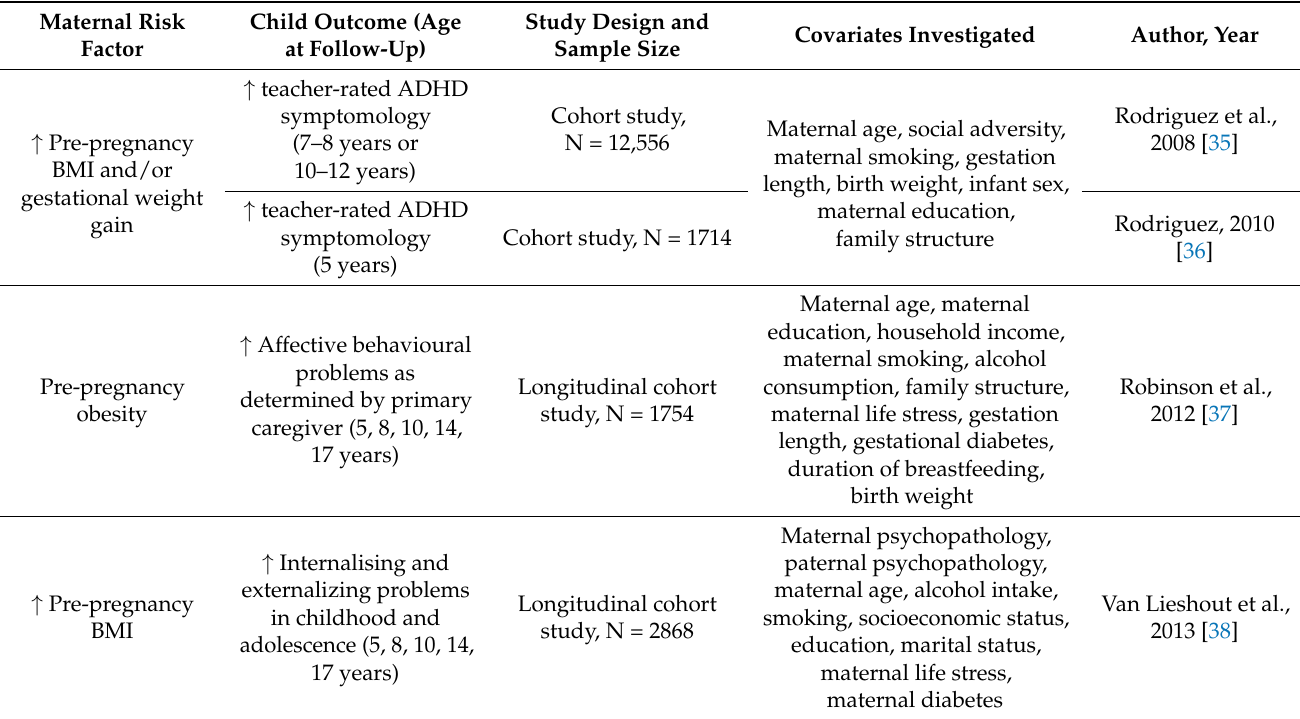
Table 2. Overview of clinical studies demonstrating an association between maternal obesity and altered behavioural outcomes in children independent of other